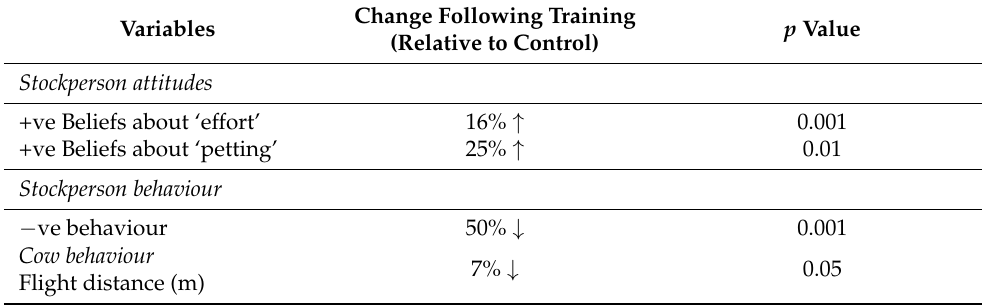
Table 1. Effects of cognitive behavioural training of dairy stockpeople (adapted from